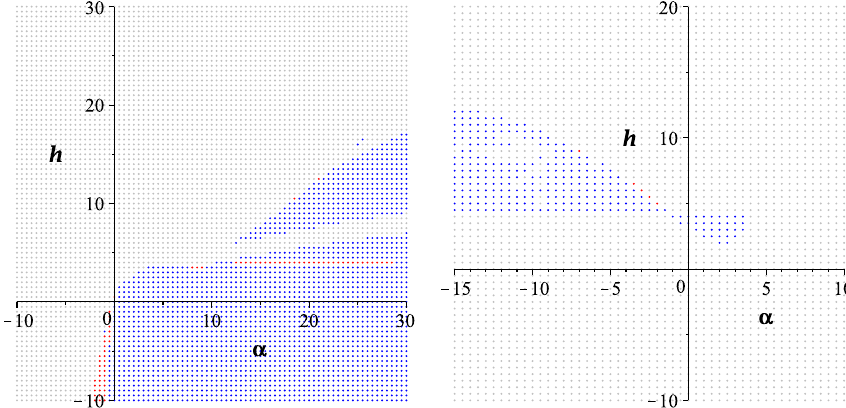
Figure 7 . Critical point pro(cid:12)les for charged black holes ( q = 2 ): the case for negative quasi- topological coupling. In each plot, red, blue, and grey points indicate two, one, and zero critical points, respectively. Left : spherical black holes. Right : hyperbolic black